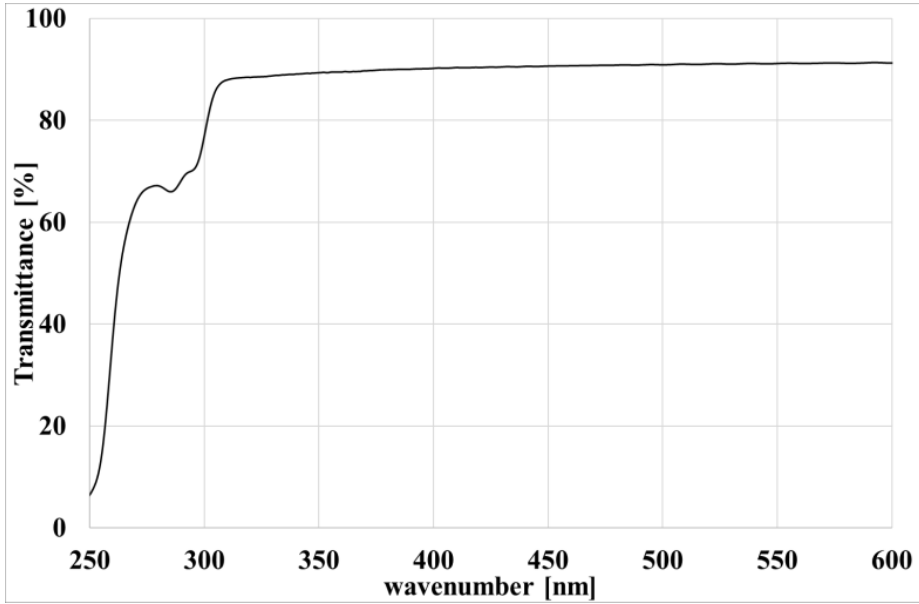
Figure 1. UV spectrum of the PVC films.